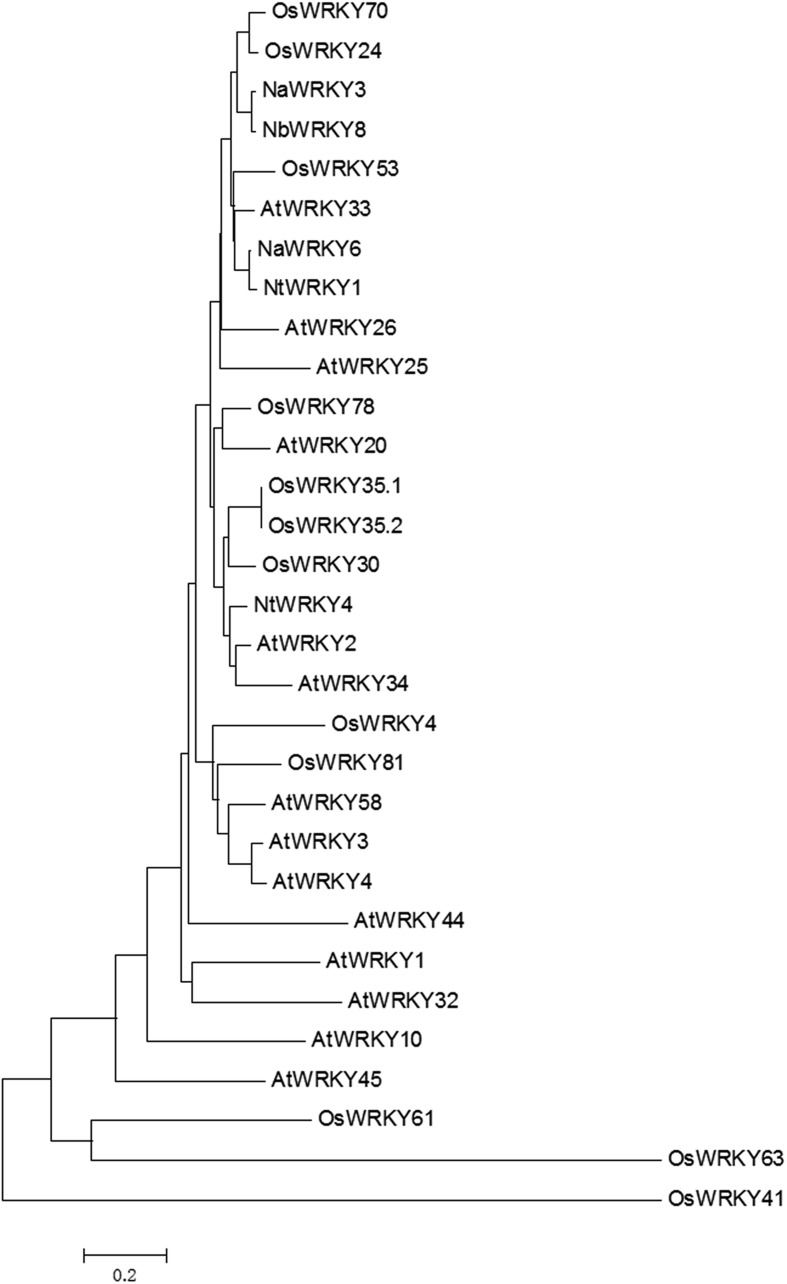
Phylogenetic relationships of Group Ⅰ type WRKY genes from different species.Neighbor-joining phylogenetic trees were produced using MEGA3.1 based on multiple sequence alignments made with ClustalX. Selected proteins accession numbers are as follows: Arabidopsis thaliana (At, Tigr ID): AtWRKY1 (At02g04880), AtWRKY2 (At02g30250), AtWRKY3 (At02g03340), AtWRKY4 (At01g13960), AtWRKY10 (At01g55600), AtWRKY20 (At04g26640), AtWRKY25 (At02g30250), AtWRKY26 (At05g07100), AtWRKY32 (At04g30935), AtWRKY33 (At02g38470), AtWRKY34 (At04g26440), AtWRKY44 (At02g37260), AtWRKY45 (At03g01970), AtWRKY58 (At03g01080); Oryza sativa (Os, Tigr ID): OsWRKY4 (Os03g55164), OsWRKY24 (Os01g61080), OsWRKY30 (Os08g38990), OsWRKY35.1 (Os04g39570.1), OsWRKY35.2 (Os04g39570.2), OsWRKY41 (Os11g45924), OsWRKY53 (05g27730), OsWRKY61 (Os11g45850), OsWRKY63 (Os11g45920), OsWRKY70 (Os05g39720), OsWRKY78 (Os07g39480), OsWRKY81 (Os12g02400); Nicotiana attenuate (Na, NCBI ID): NaWRKY3 (AY456271), NaWRKY6 (AY456272); Nicotiana benthamiana (Nb, NCBI ID): NbWRKY8 (AB445392); Nicotiana tabacum (Nt, NCBI ID): NtWRKY1 (AF096298), NtWRKY4 (AF193771).